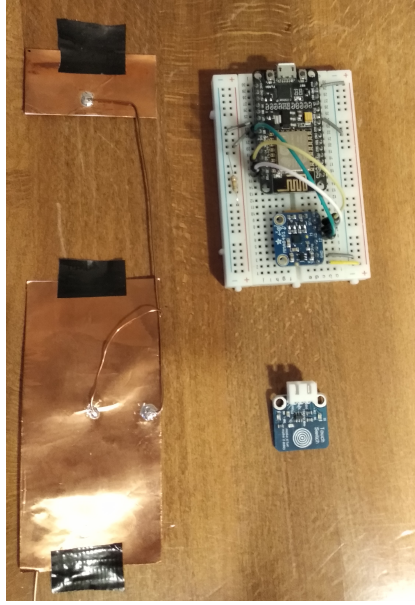
Figure 6. Final design of the